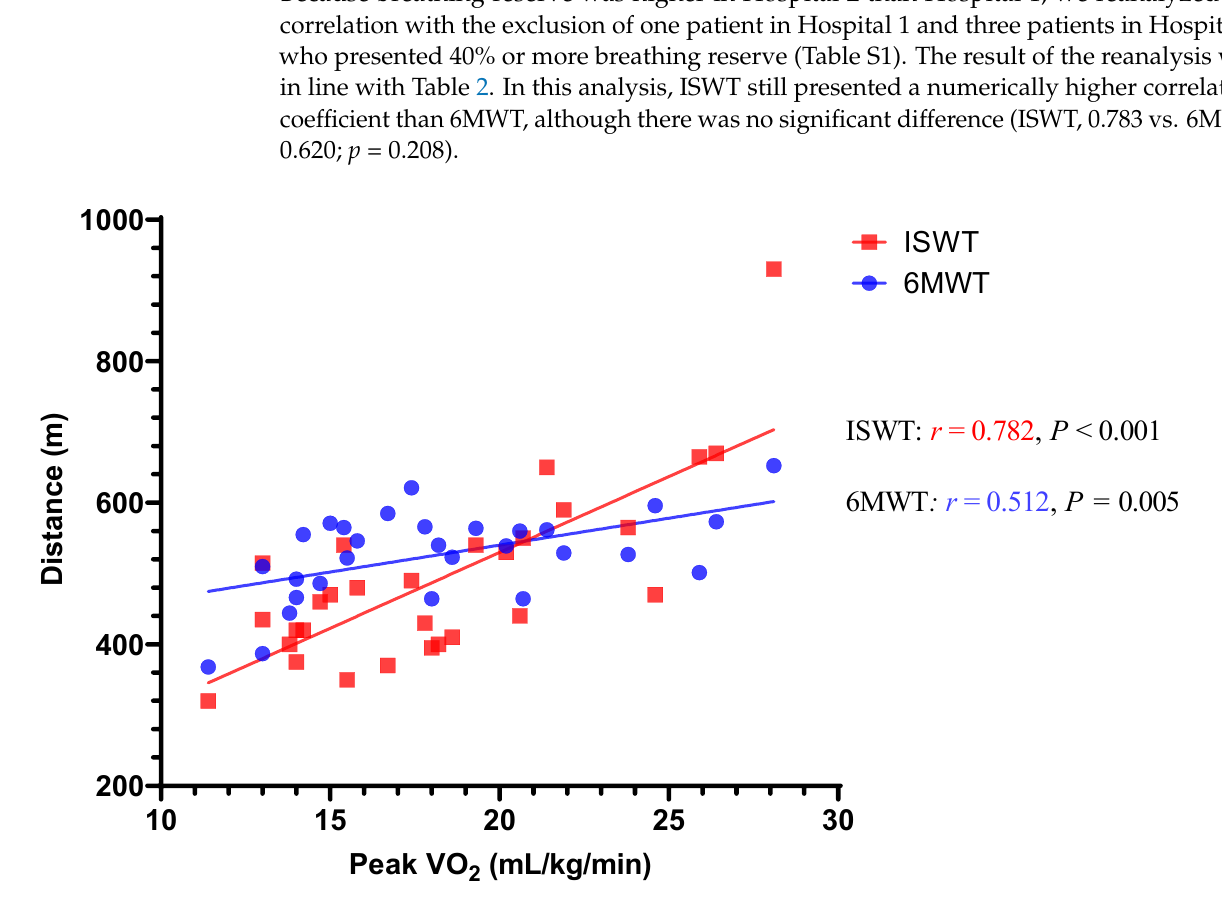
Figure 2. The correlation analysis of ISWT and 6MWT in 29 patients in both hospitals. The validity of ISWT and 6MWT was analyzed using Pearson’s correlation coefficient ( r ). Both walking tests presented a significant correlation with peak VO 2 of the cardiopulmonary exercise test. However, ISWT presented a higher correlation than 6MWT. Abbreviations: 6MWT, 6 min walking test; ISWT, incremental shuttle walking test; peak VO 2 , peak oxygen consumption. Table 2. Comparison of the correlation between peak oxygen uptake and distance of ISWT and 6MWT. Total ( n = 29)